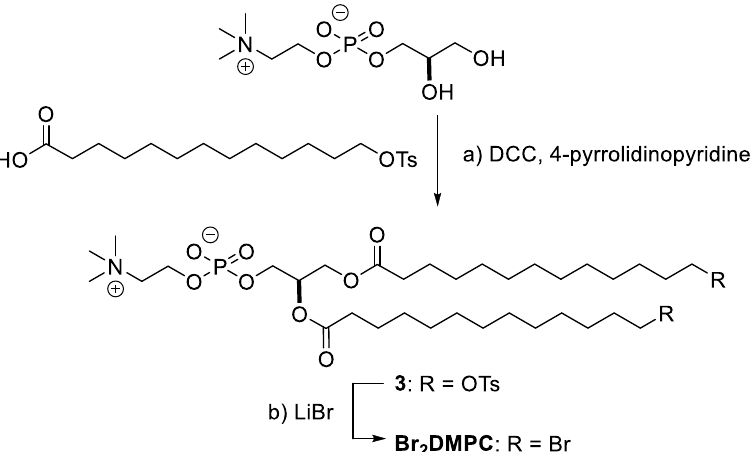
Figure 2. Crystal structures of the complex with lipidic ligands with halogen moiety. Moth chemosensory protein CSPMbraA6 with bromohydrocarbon chain (PDB ID: 1N8U) ( A ). Moth pheromone binding protein BmorPBP with iodohexadecane (PDB ID: 2P71) ( B ). Hydrocarbon chain of the ligands were shown in sky-blue, and Br and I were shown in purple and magenta, respectively.